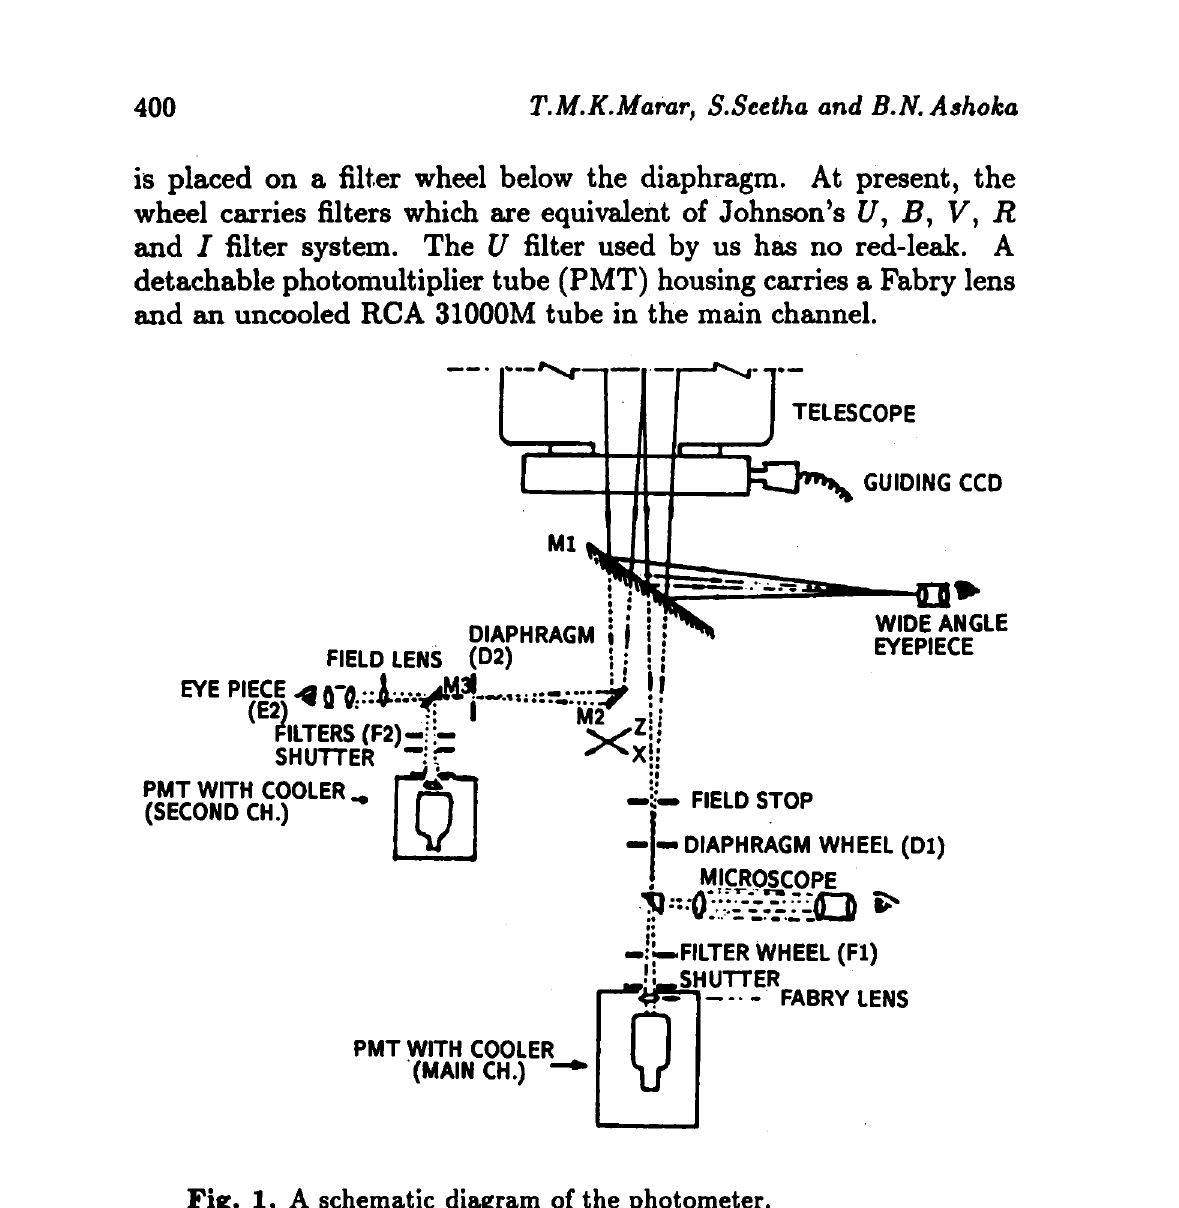
Fig. 1 . A schematic diagram of the